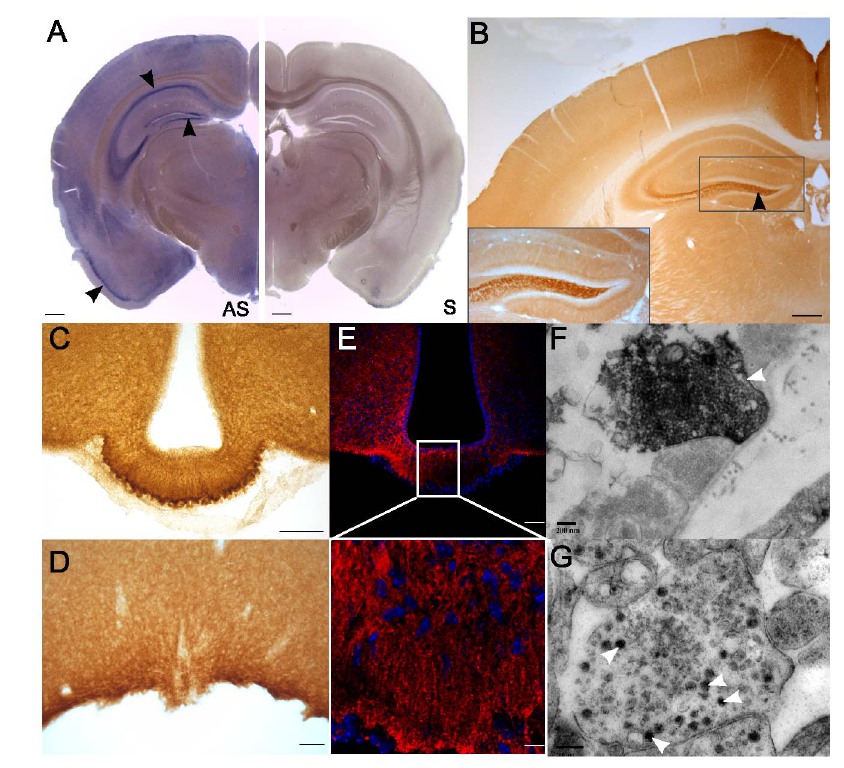
Figure 2. Rbcn-3 a is expressed in exocytosis vesicles in the external layer of the median eminence. (A) ISH with a mouse Dmxl2 antisense probe (AS) and a sense probe (S). (B) Immunolabeling with an antibody against Rbcn-3 a revealed high levels of Dmxl2 /Rbcn-3 a expression in the dentate gyrus, the CA1 and CA3 regions of the hippocampus, and the cortex (black arrowheads). Scale bars, 200 m m. (C and D) Rbcn-3 a was found to be strongly expressed in the external layer of the ME (C) and the OVLT (D). Scale bars, 100 m m. (E) Confocal analysis with an antibody against Rbcn-3 a showed punctate staining in the median eminence and staining of the long processes extending from the cell bodies lining the third ventricle. (F and G) Rbcn-3 a immunoreactivity was observed in small clear vesicles and LDCVs at the extremities of the axons in the ME (white arrow). Scale bar, 0.2 m m.